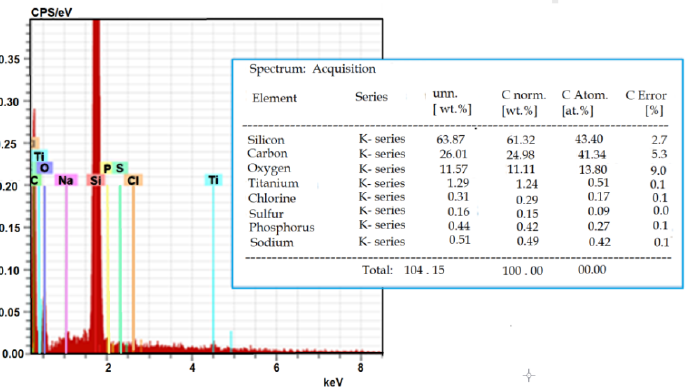
Figure 10. Representative EDS spectrum and elemental composition of the elements detected by EDS in CHO cells.